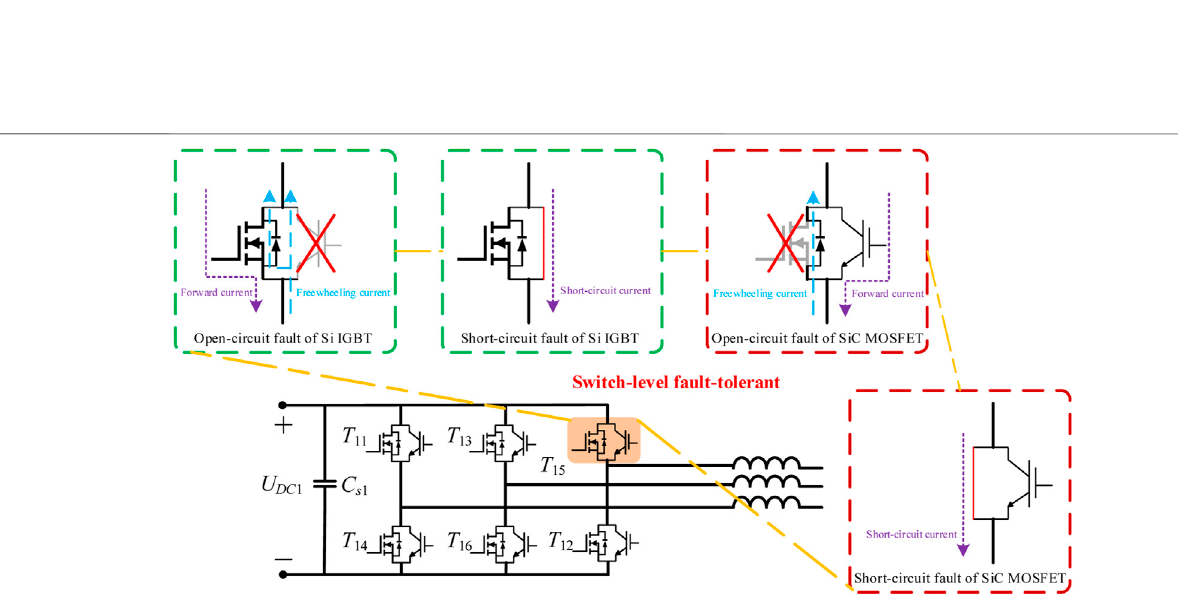
Frontiers in Energy Research |